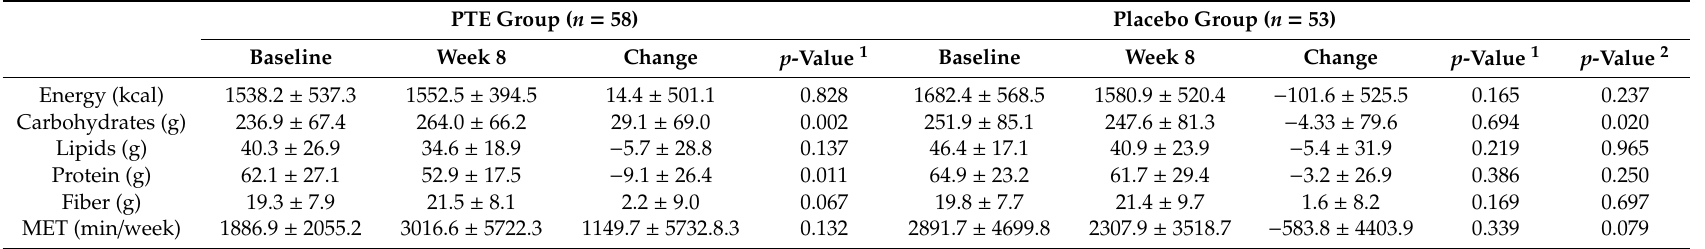
Table 3. Intake of major nutrients and MET values in the PTE and placebo groups measured at baseline and at 8